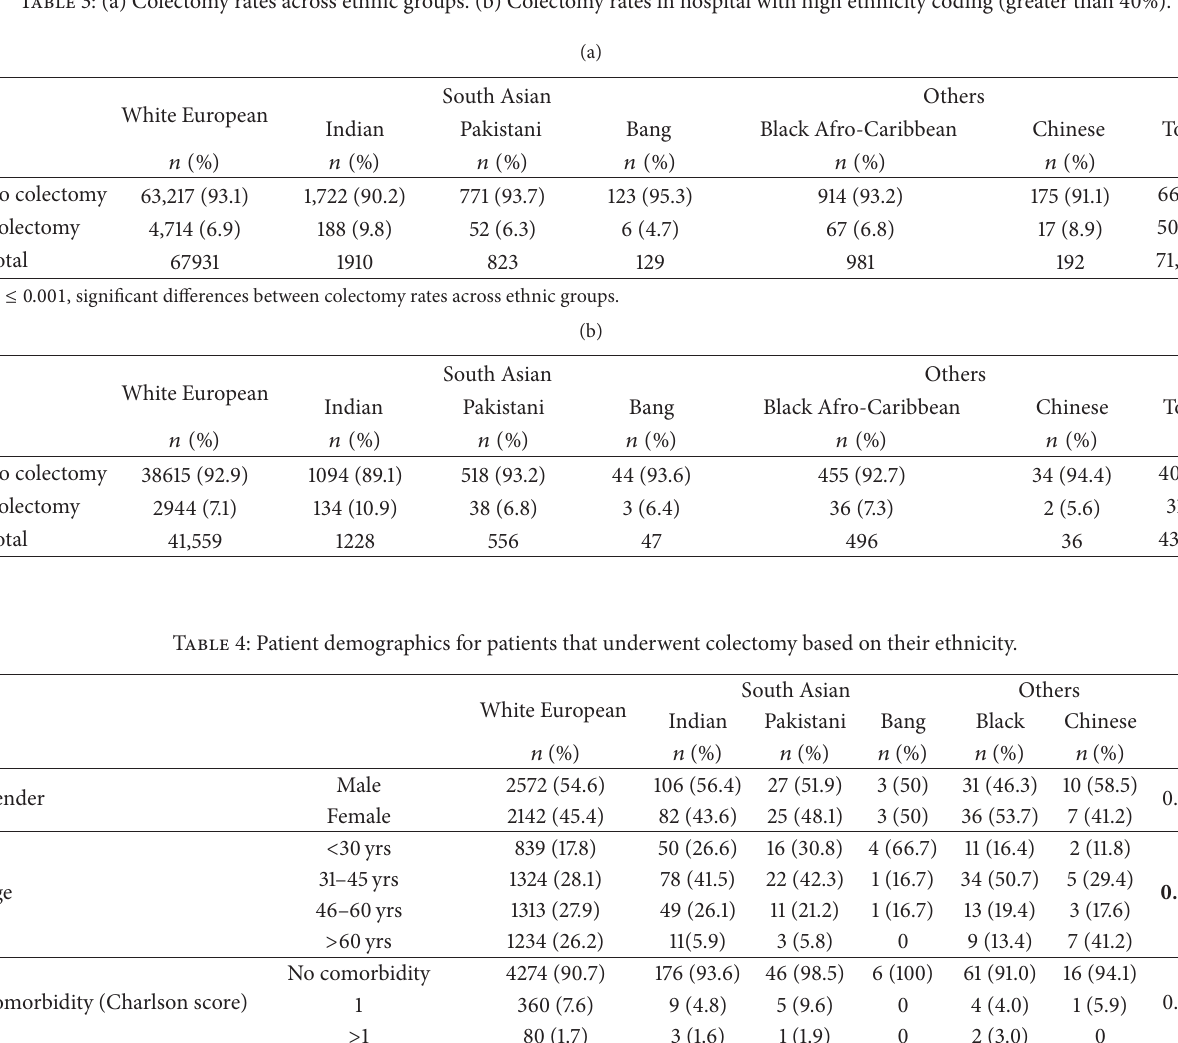
Table 3: (a) Colectomy rates across ethnic groups. (b) Colectomy rates in hospital with high ethnicity coding (greater than 40%).